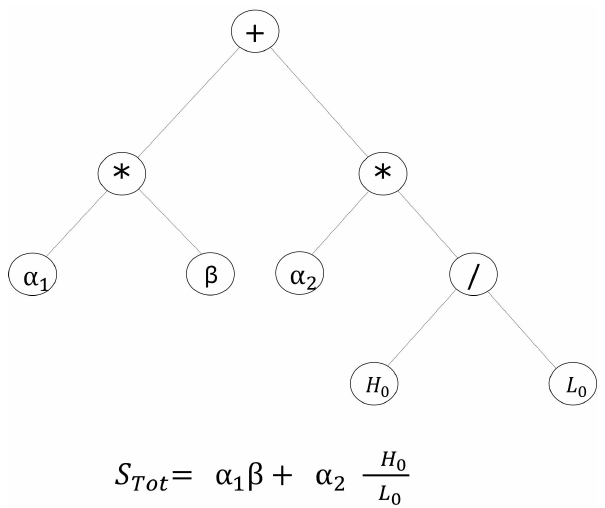
Figure 3. Schematics of the GP structure and principle of operation for an example of the simple total swash predictor. α 1 and α 2 are the coefficients; β , H 0 and L 0 the variables; and + , ∗ and / the mathematical